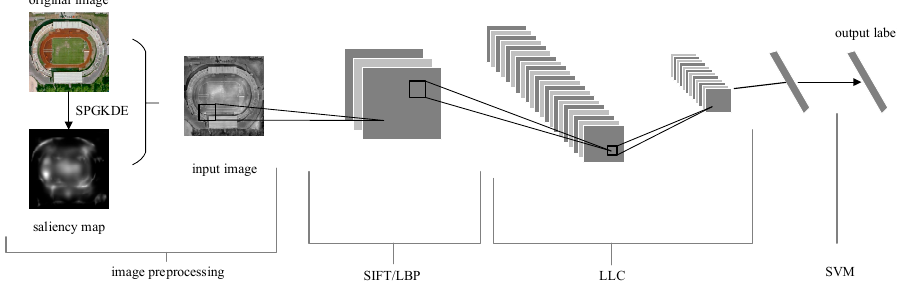
Figure 1. The flow chart of the proposed method.